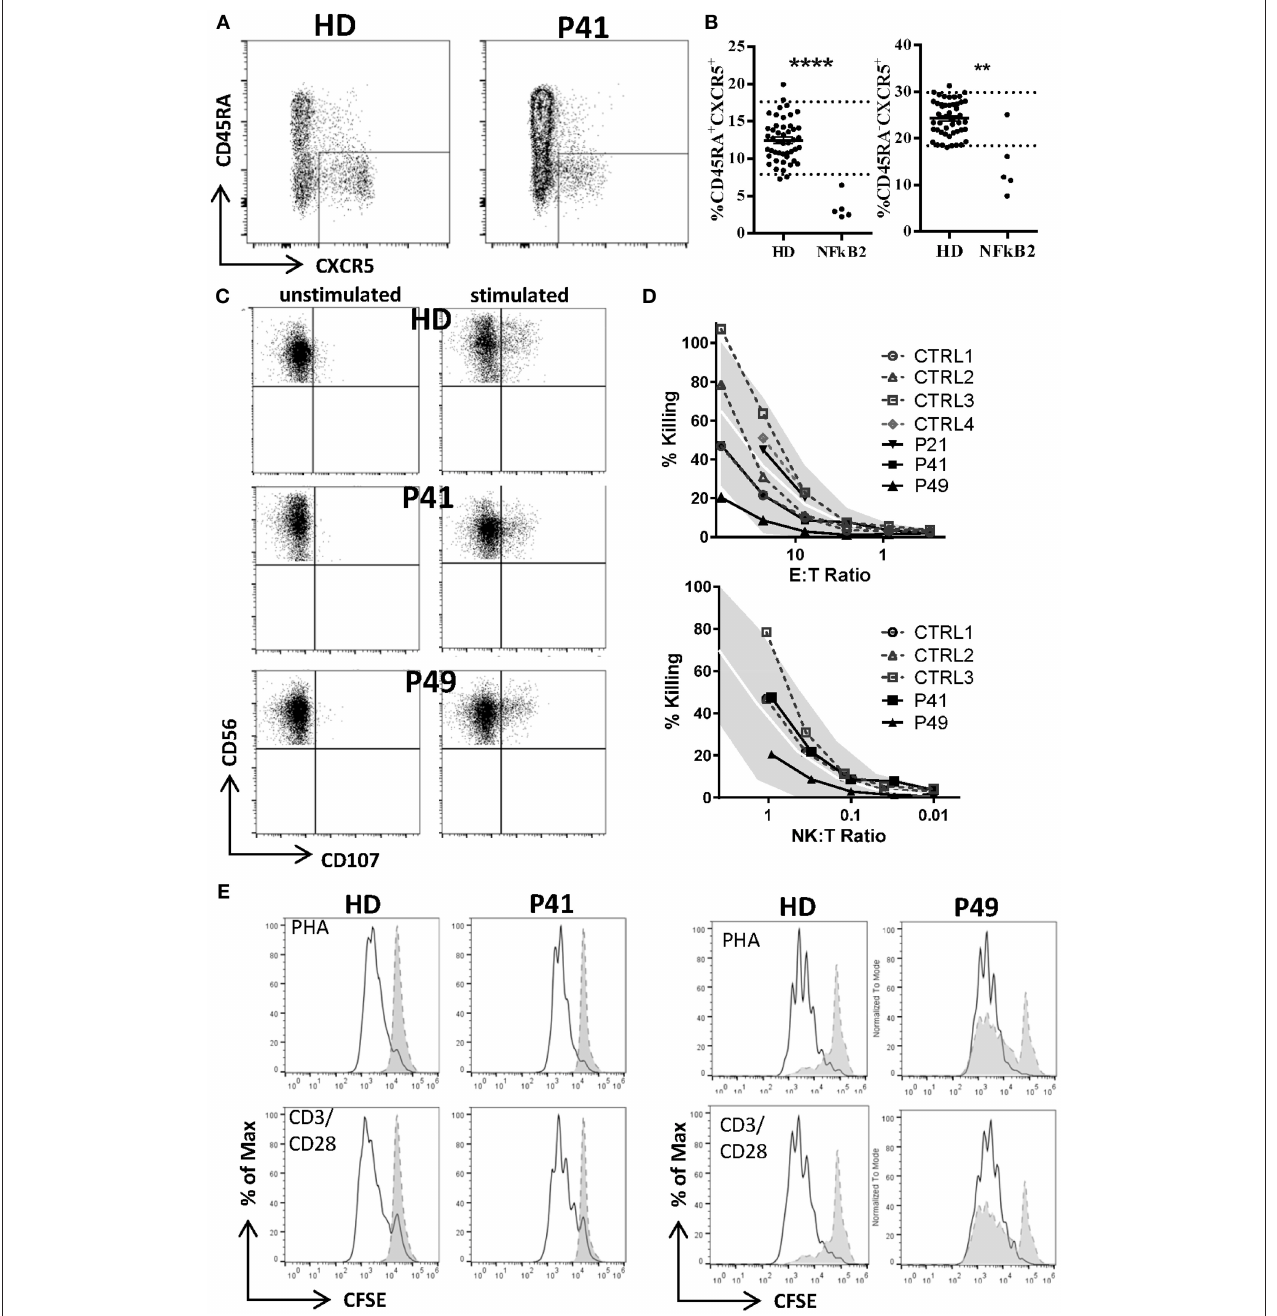
FIGURE 2 | Decreased T follicular helper (cTFH), but normal NK and T cell function in NFKB2 -mutated patients. (A) Reduced frequency of circulating T follicular helper cells (CXCR5posCD45RAneg) in CD4T cells of patients with NFKB2 mutation. FACS plots shows example staining of a healthy donor (HD) and P41. (B) Percentage of CXCR5pos in CD45RA + (left) and memory (CD45RAneg, right) CD4 T cells. (A,B) Dotted lines in graphs represent 95% percentile of 47 healthy donors. Values of healthy donors are depicted as means ± SD. Statistical significance was assessed by Mann-Whitney test (** P < 0.01, **** P < 0.0001). (C) Normal NK and T cell function. (C,D) PBMCs were stimulated either with medium alone or K562 cells for 2.5h in presence of anti-CD107a-PE. Lytic exocytosis of NK cells (CD56 + ) are measured by CD107a staining. (D) NK cytotoxicity was analyzed by standard 51Cr release assay. Target cell lysis by NK cells: PBMC were incubated with K562 target cells in a standard 51Cr release assay. The percentage of NK cells among PBMC was measured by flow cytometry to determine the NK:target cell ratio. The gray shaded area represents the range of normal values (5th − 95th percentile). (E) T cell proliferation was measured by CFSE dilution after 1 week of stimulation with PHA (1.25 ug/ml) or CD3 (100ng/ml) with CD28 (200ng/ml).